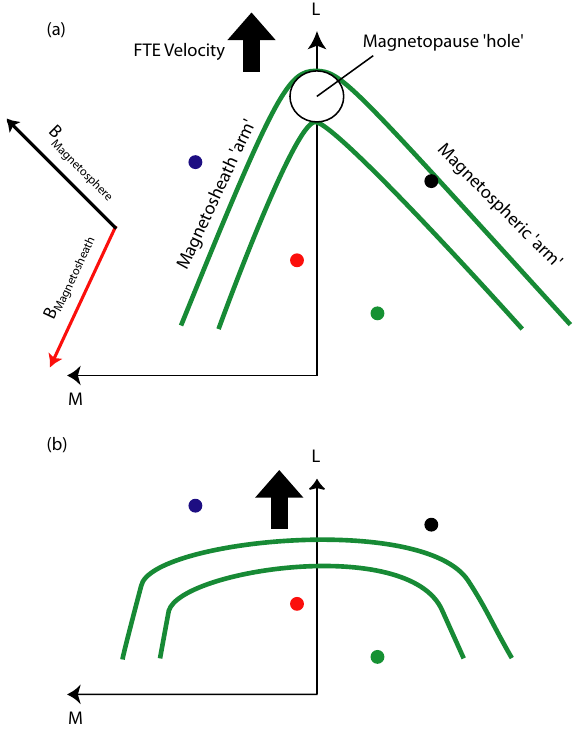
Fig. 9. (a) A sketch of a reconnected flux tube (“elbow-shaped flux rope model” FTE) formed by the magnetic geometry shown in Fig. 5. The figure shows a view of the magnetopause plane as it would be seen from the magnetosheath. The FTE is connected to the Southern Hemisphere, and moves upward in the L direction (indicated by the thick black arrow), and peels away flux such that the open flux always passes through a “hole” in the magnetopause, and the hole moves poleward. The locations of the Cluster space- craft are marked by coloured dots (using the same colour scale as Fig. 2). The location of Cluster 4 is inconsistent with observing the magnetospheric “arm” of this event if Cluster 2 observed the magnetosheath “arm”. A less simplistic interpretation of this model is shown in (b) , where the kink in the flux tube relaxes to form an intermediate section which is embedded on the magnetopause (as sketched by Farrugia et al., 1987). Unless the magnetic shear across the magnetopause is much higher, this can provide a large azimuthal extent to an FTE formed by the process sketched by Rus- sell and Elphic